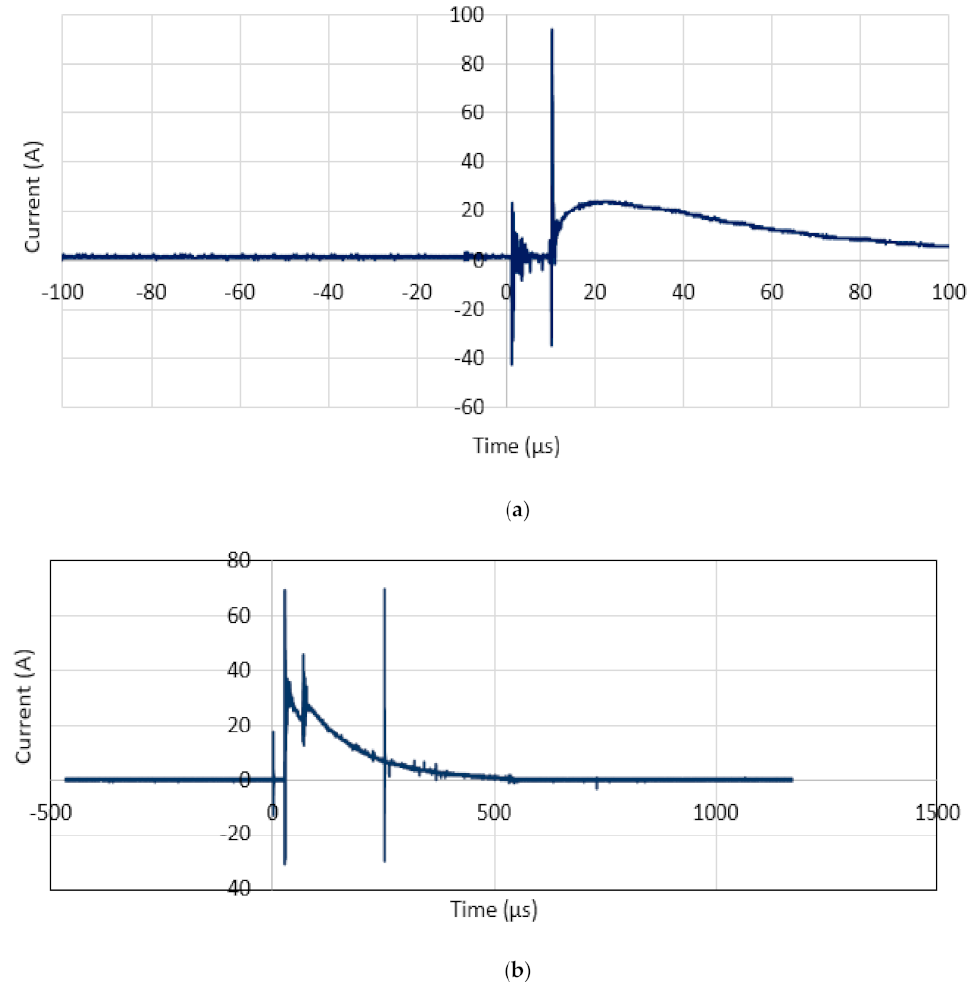
Figure 5. Current flows through the power adapter, measured with current transformer (CT) 3 ( a ) Configuration (b) installed at site 1, for the case of no damage to the modem; ( b ) Configuration (a) installed at site 2, for the case of damage to the